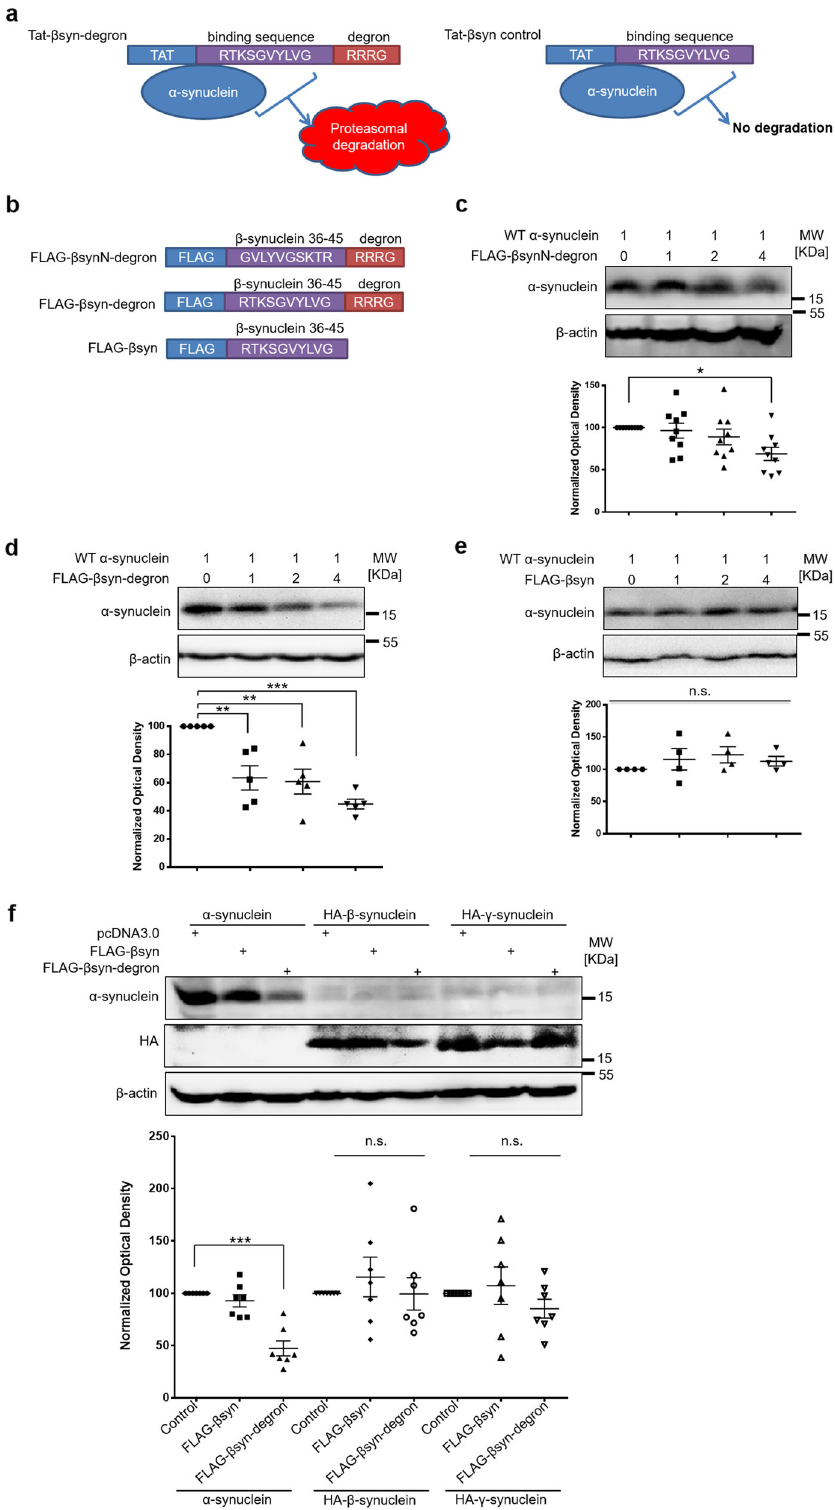
well-characterized in vitro model of PD 26 . As shown in Fig. 4, MPP + treatment (20 µM; 48 h) induced the dramatic death of dopaminergic neurons in rat primary cultures of the ventral midbrain. This was demonstrated by the signi fi cant decrease in the level of tyrosine hydroxylase (TH), a dopaminergic neuronal marker protein (Fig. 4a, c) and in the numbers of TH-positive neurons (Fig. 4d, e). Bath application of the Tat- β syn-degron